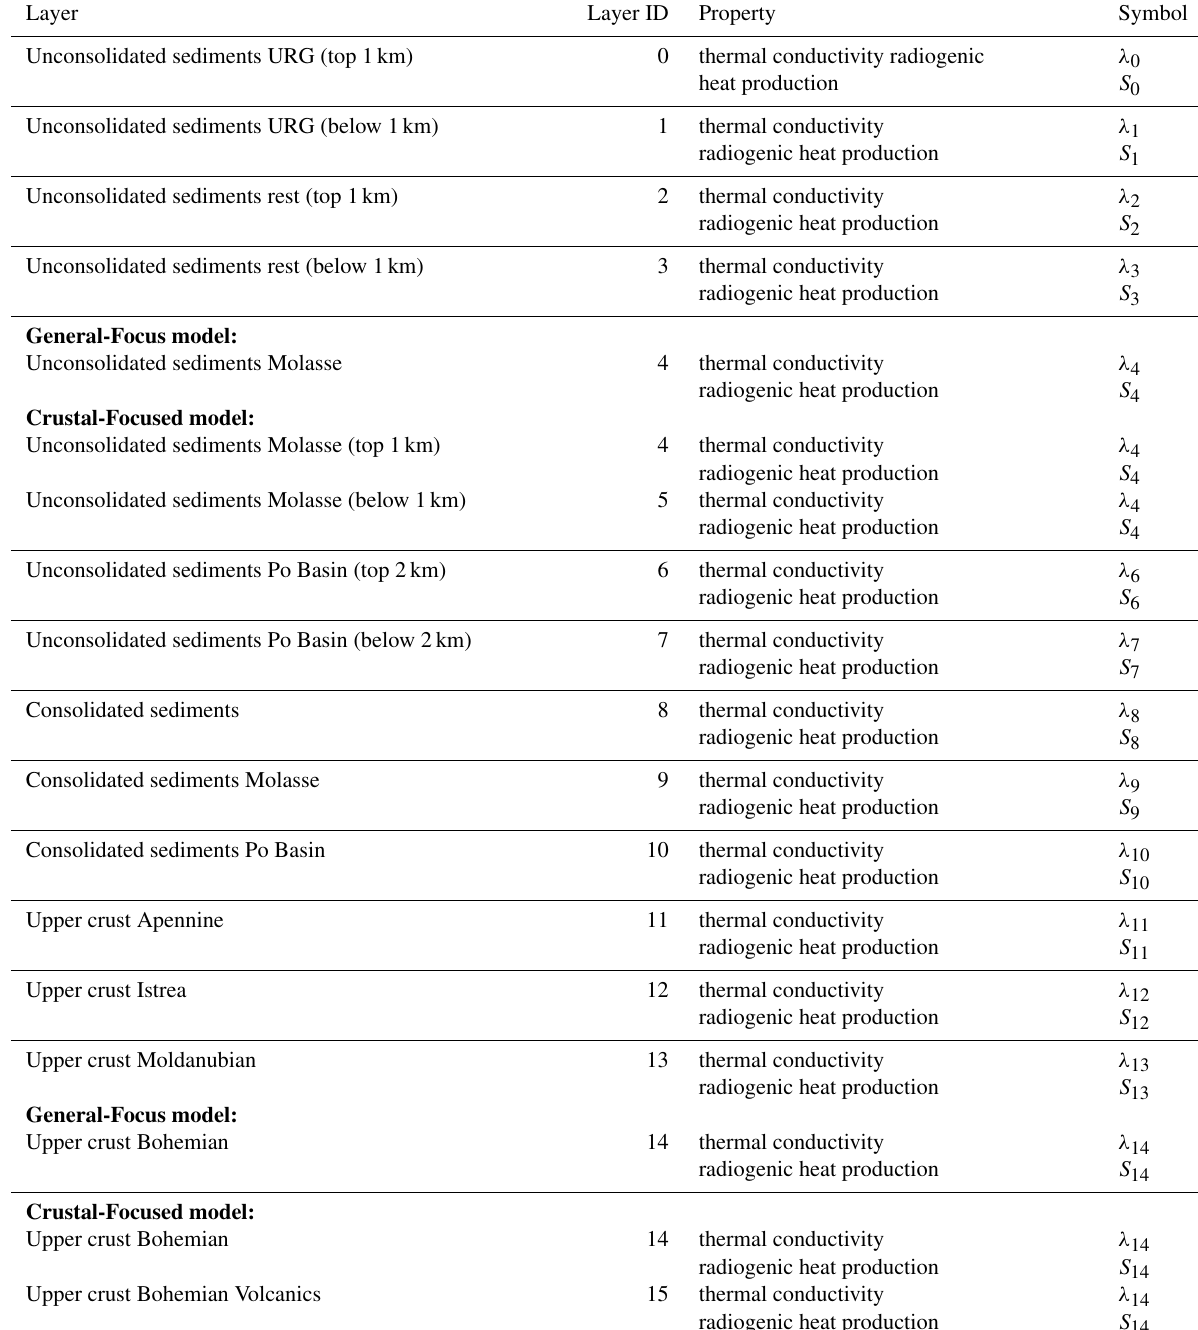
λ 0 S 0 heat production radiogenic heat production S 1 radiogenic heat production S 2